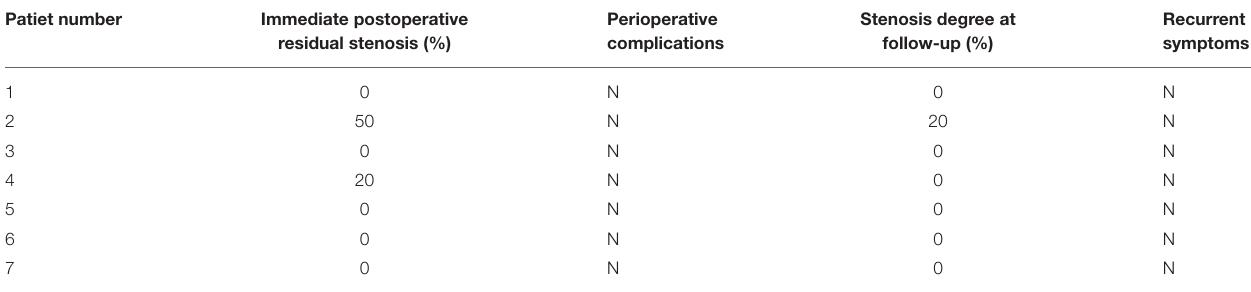
TABLE 3 | Clinical and imaging outcomes in-hospital and during follow-up. Patiet